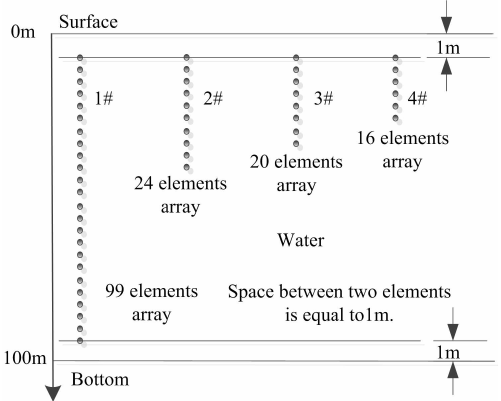
Figure 2. The layout of the receiver arrays. 1# array is a large vertical array, its aperture is 98 m. 2#, 3#, and 4# arrays are all small vertical linear ones, their apertures are 23 m, 19 m and 15 m, respectively.